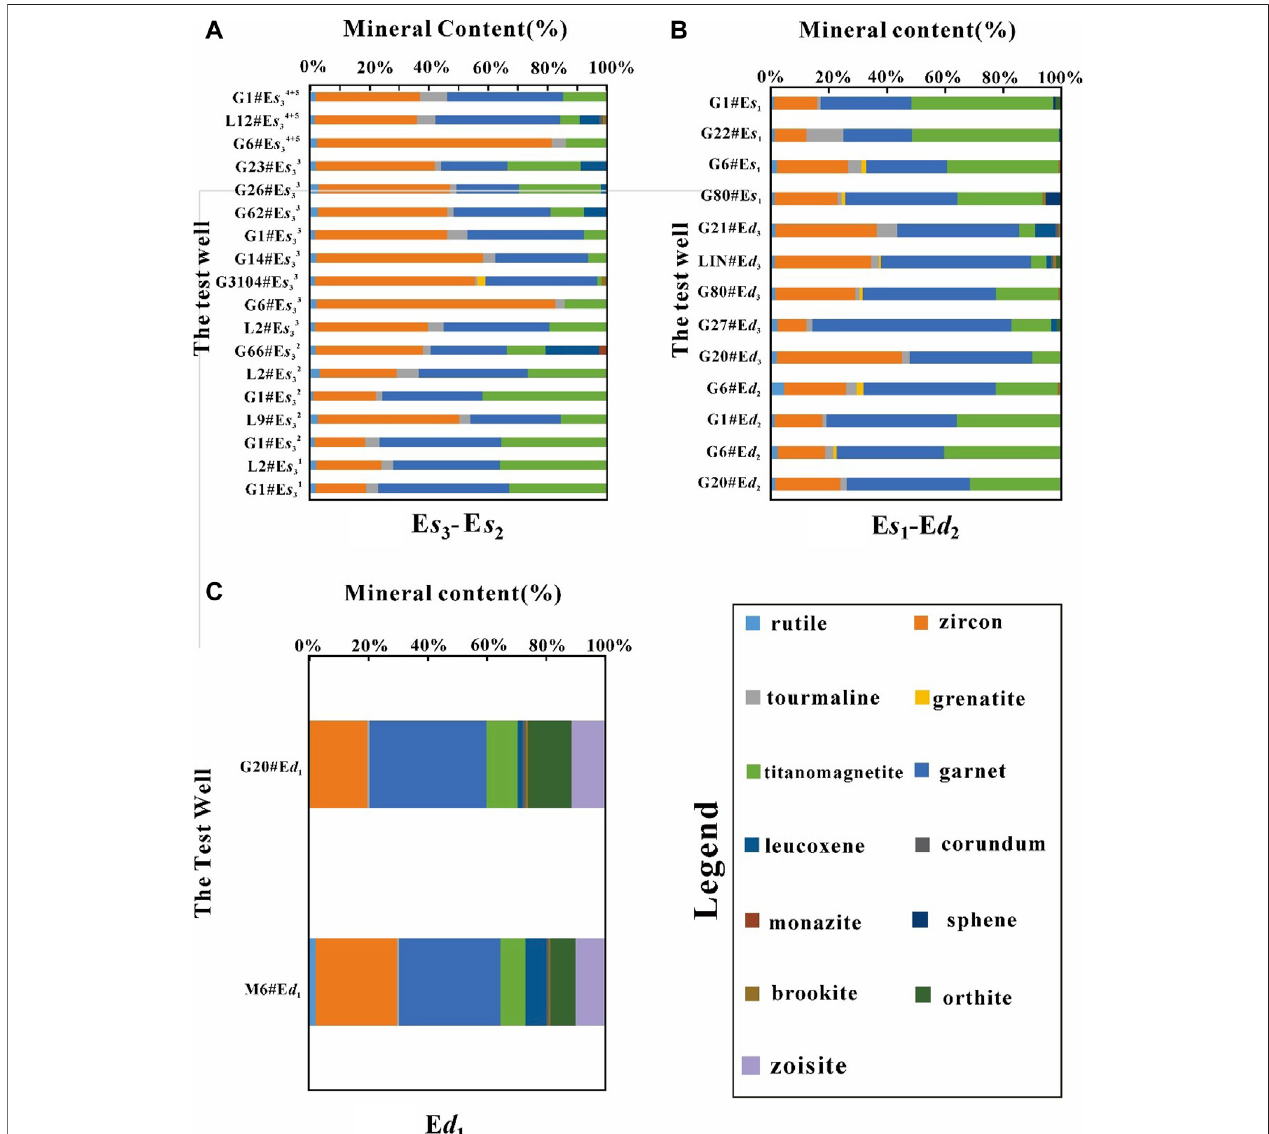
FIGURE 4 | Histogram of the percentage of heavy minerals in (A) the E s 3 -E s 2 period, (B) Es 1 -E d 2 period, and (C) E d 1 period.